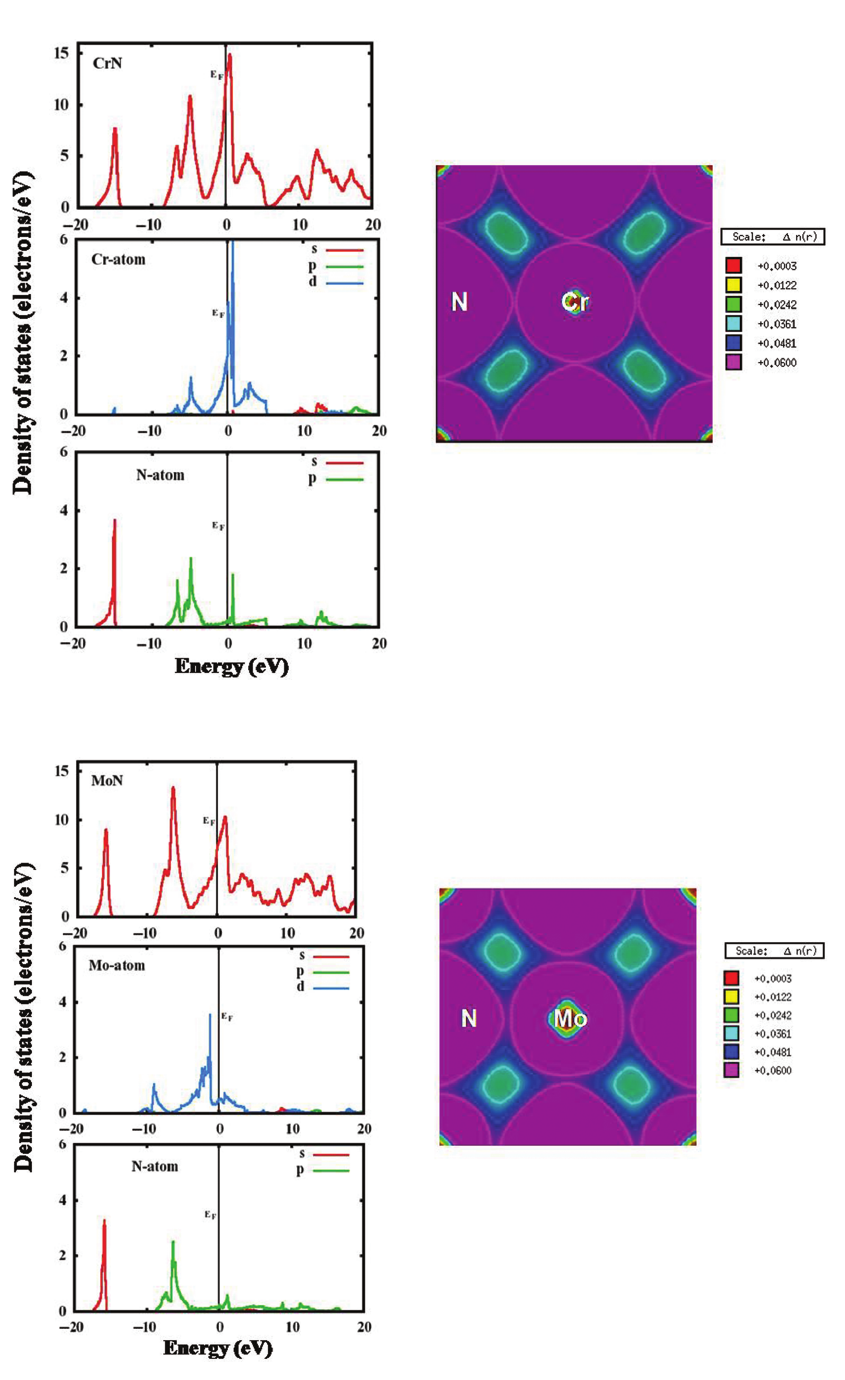
Figure 10: Electronic DOS and 2D charge density of